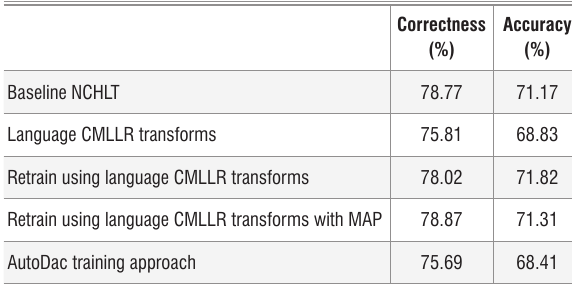
Correctness and accuracy results for various automatic speech recognition data sharing set-ups